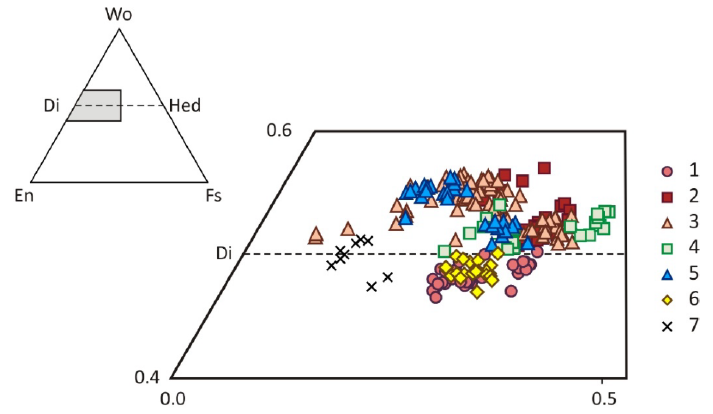
Figure 11. Pyroxene from pyroxenite in binary diagrams. 1–3 = pyroxenes from a pyroxenite fragment with remnant dolerite: dolerite (1), pyroxenite (2), garnet-bearing pyroxenite (3); 4–6 = pyroxenes from other pyroxenite fragments: pyroxenite (4), garnet-bearing pyroxenite (5), biotite-bearing pyroxenite (6); 7 = pyroxenes from the experiments of Mollo et al. [30].